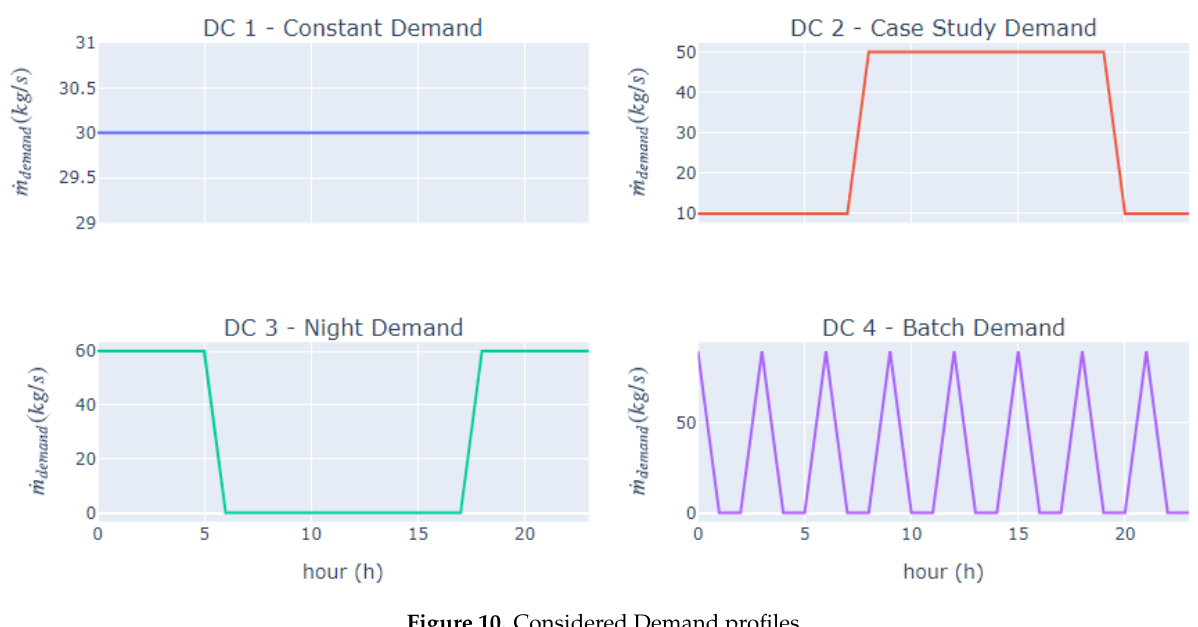
Figure 10. Considered Demand profiles.